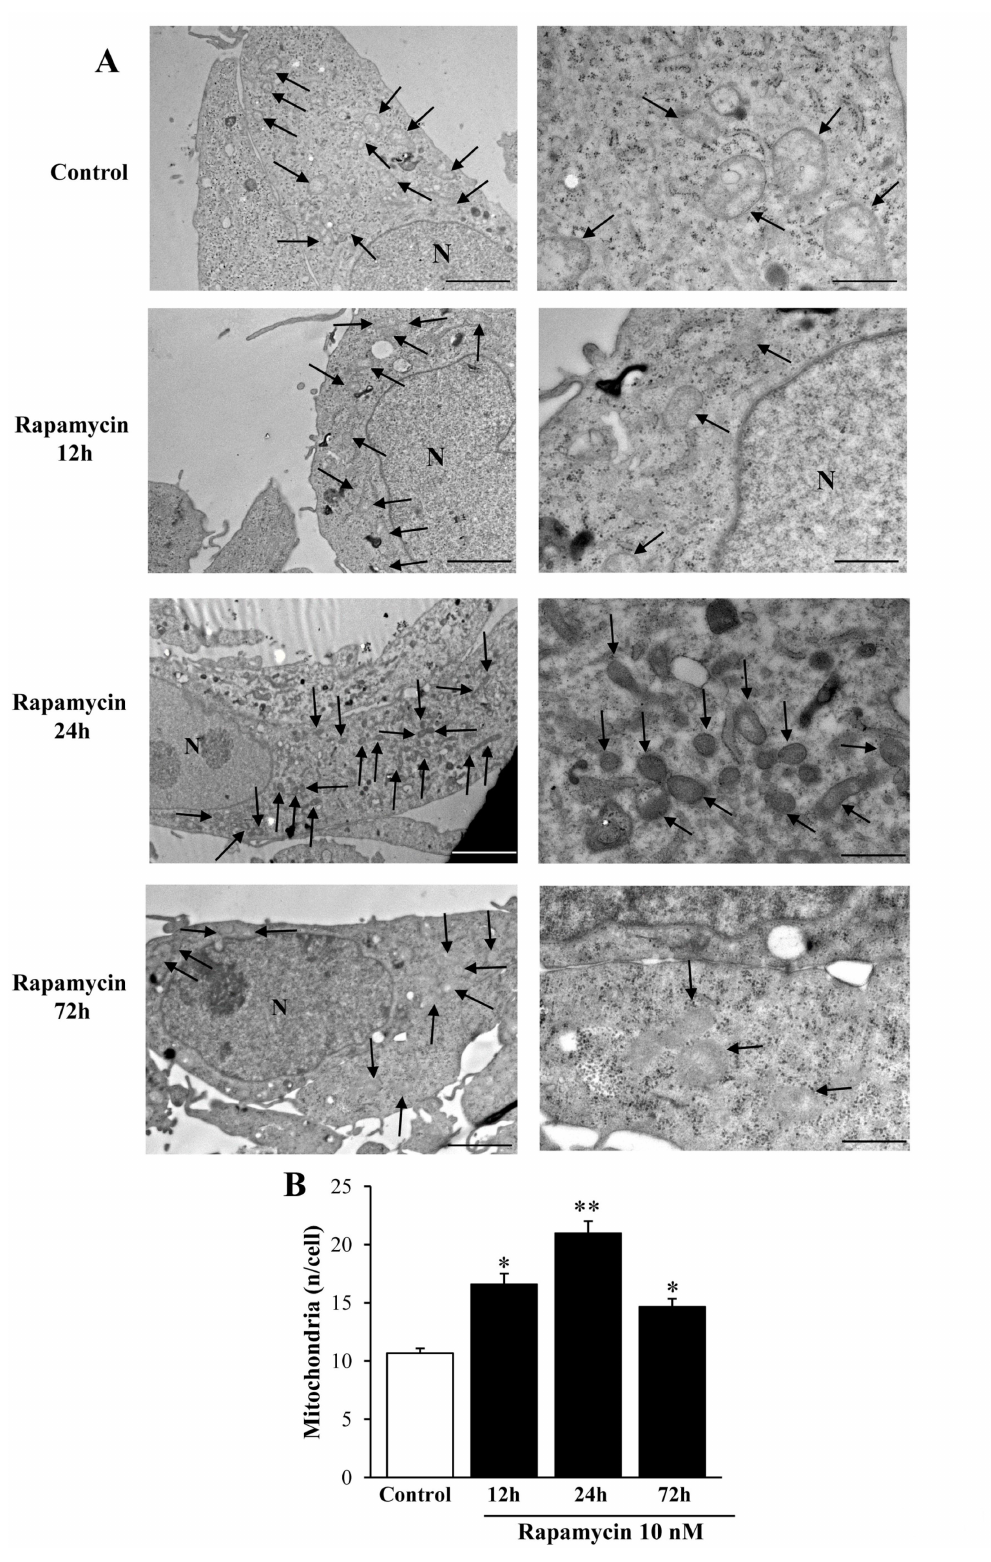
Figure 3. Rapamycin time-dependently increases mitochondrial number in U87MG cell line. ( A ) Representative TEM micrographs showing mitochondria (indicated by black arrows) from Control and from di ff erent time of continuous rapamycin 10 nM exposure. ( B ) Graph reports the number of mitochondria per cell. Values are the mean ± S.E.M. from 50 cells per group. ∗ p ≤ 0.05 vs. Control; ** p ≤ 0.05 vs. other groups. Scale bars = 1 µ m (low magnification) and 0.56 µ m (high